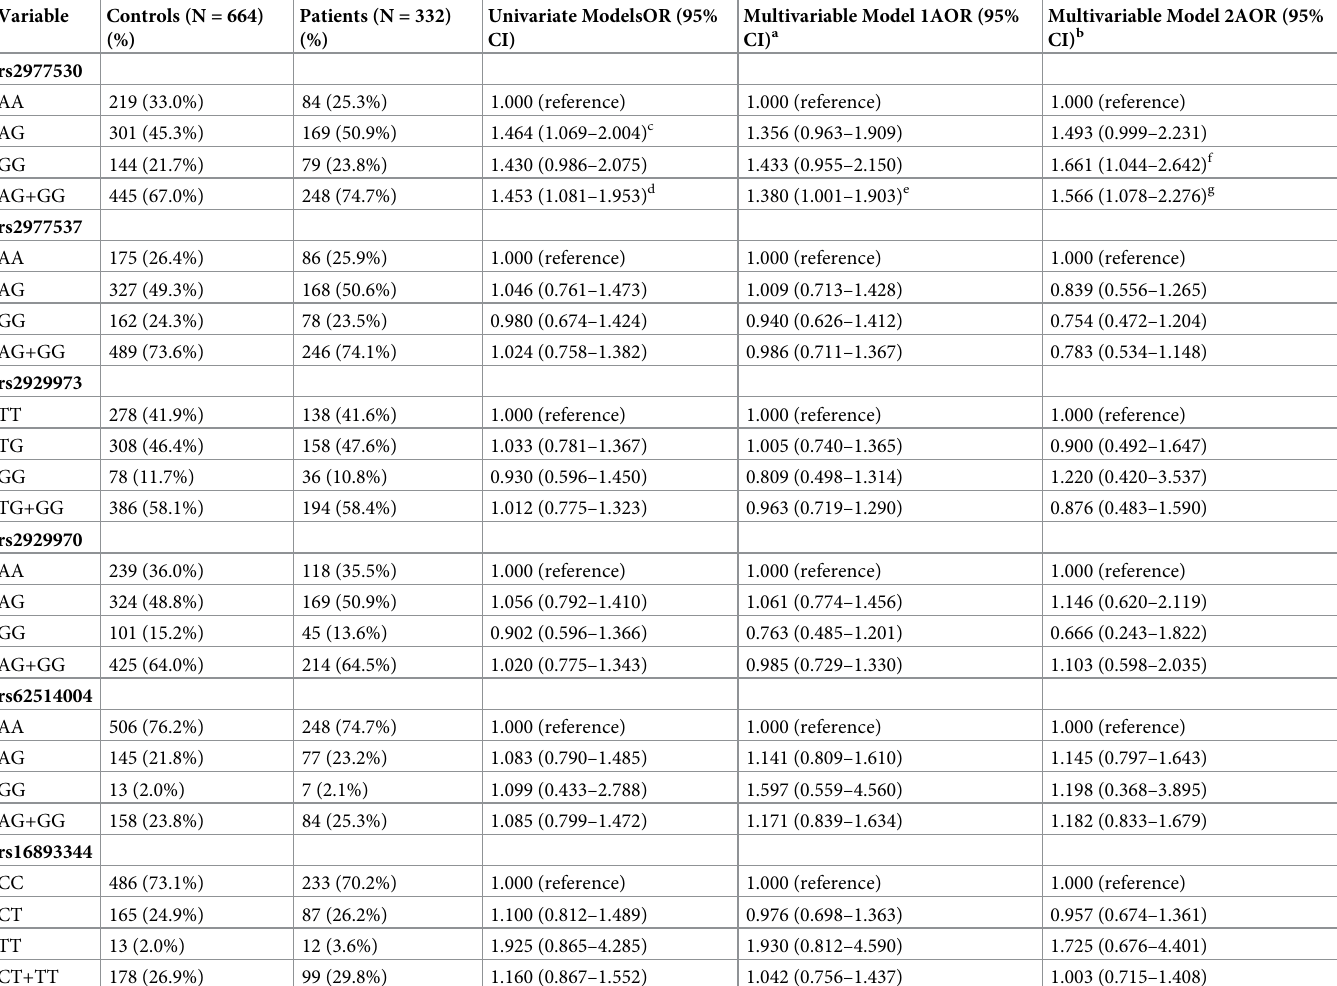
Table 2. Genotyping and allele frequency of WISP1 single nucleotide polymorphism (SNP) in HCC and normal